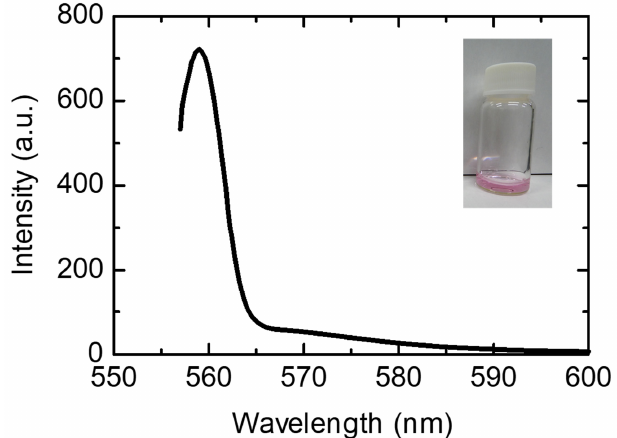
Figure 6. Aqueous solution containing fluorescent stained HGHGH nanoparticles (inset photo) and its fluorescence spectrum (main figure). Nanomaterials 2021 , 11 , x FOR PEER REVIEW